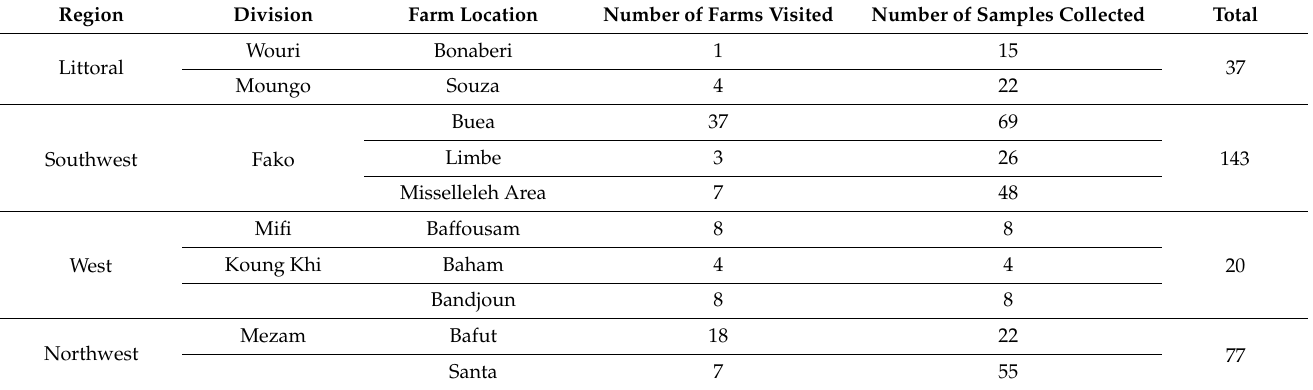
Table 1. Statistics on sample collection sites, number of farms visited and samples collected per